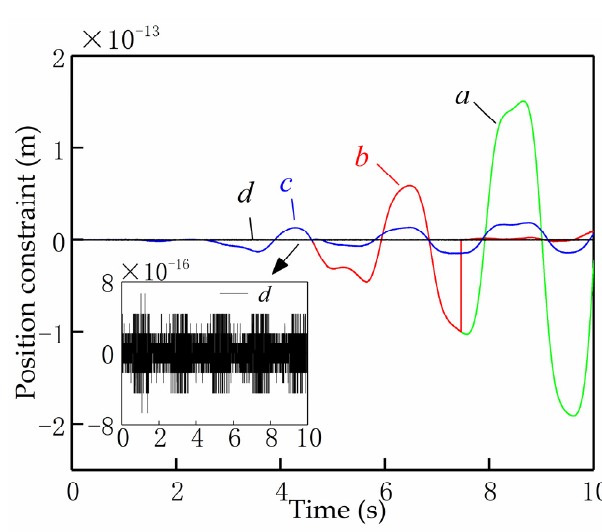
Figure 4. The violation of position constraint in the x-direction.